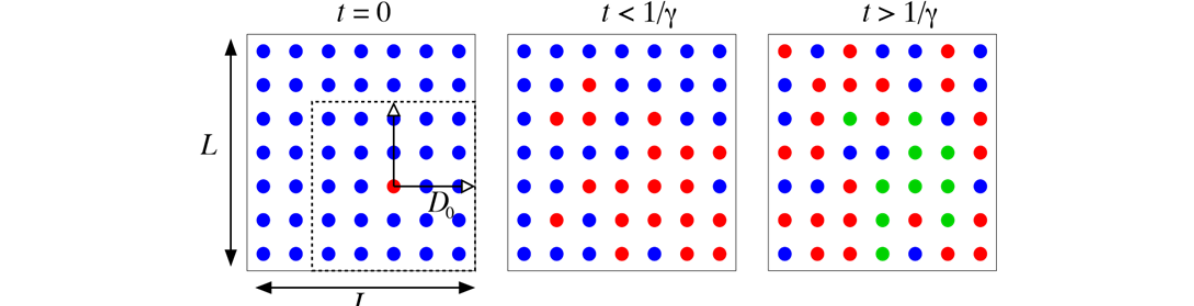
Figure 1. Illustration of the agent-based simulation model on a 2D grid of size L × L ; in this illustration L =7, while in our simulations we considered L =1000. At t =0 (left panel) all the population is susceptible (blue dots), except for one infected individual (red dot). For a period t < 1/ γ (middle panel) the original infected individual can infect others in a neighborhood within a range ± D 0 in each direction (shown by the dashed square), and each of those infected individuals also infects others within a corresponding range. For t > 1/ γ (right panel) some of the infected individuals have recovered (green dots), depending on when each was